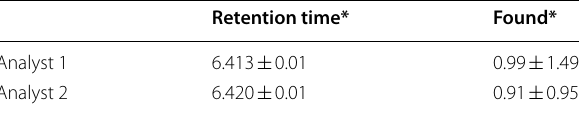
Table 3 Ruggedness data of the developed